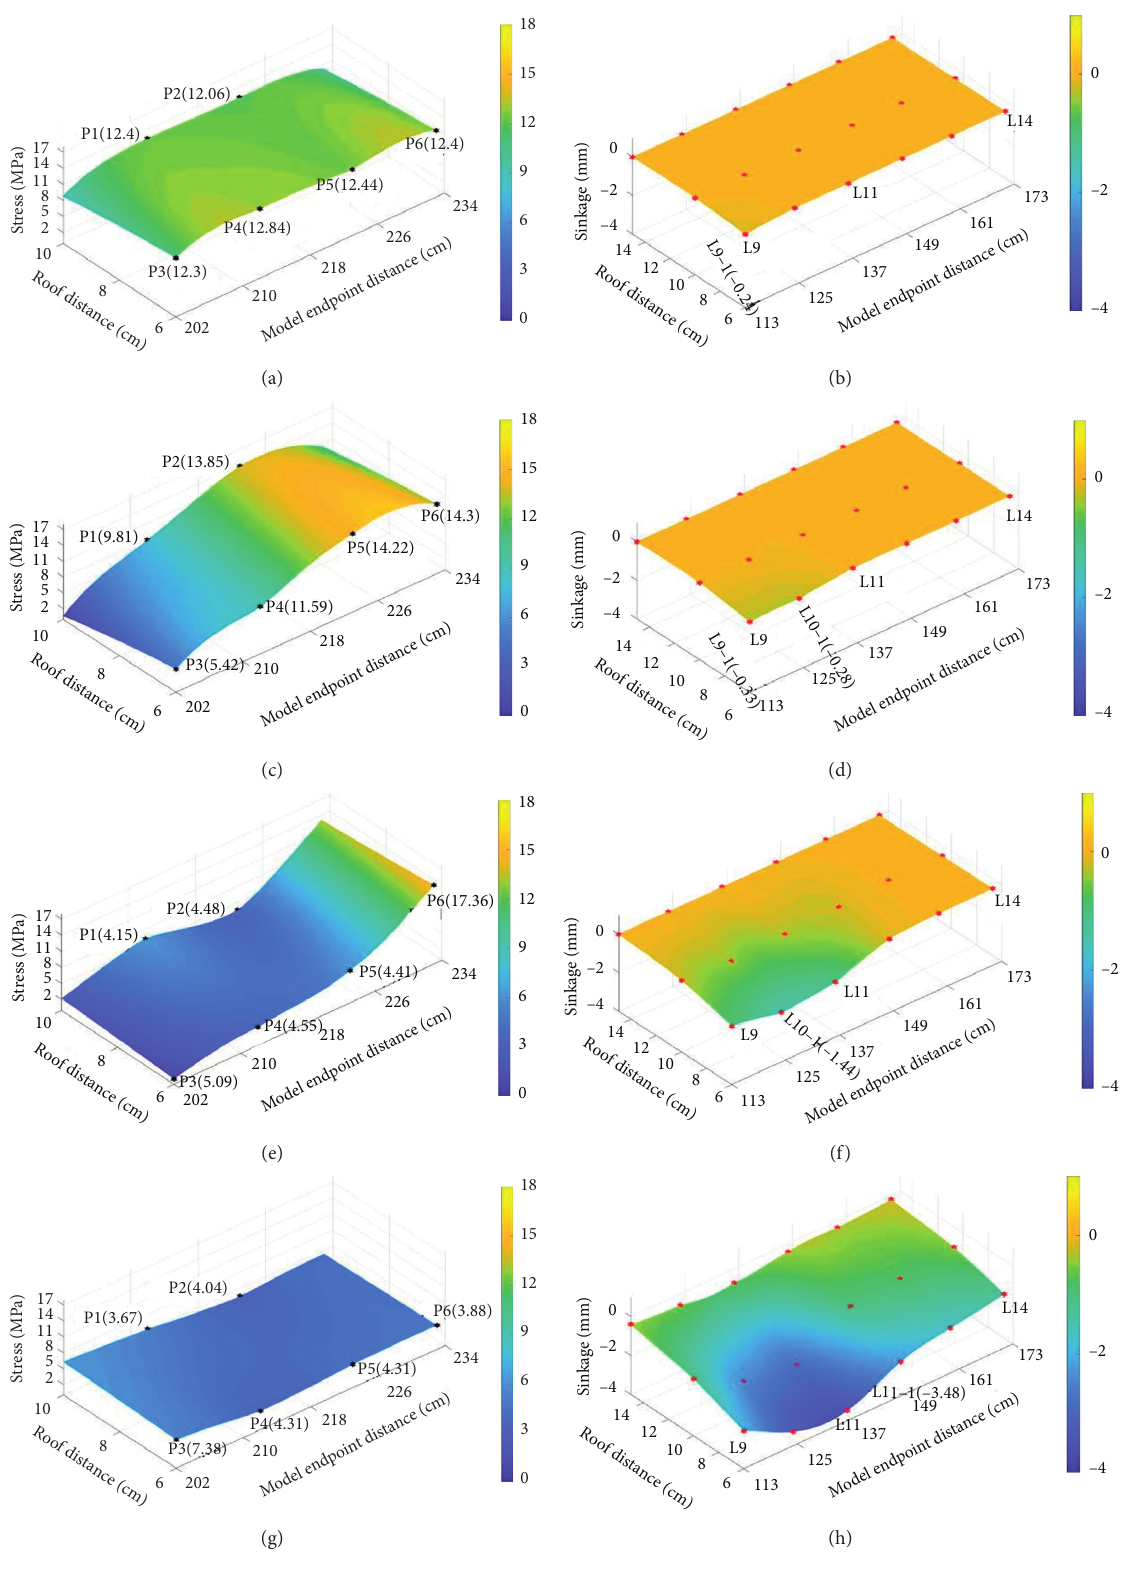
Figure 10: Lower roof stress and overlying rock subsidence in the four-step excavation of the stope structure with 8m ore pillars: (a, b) first step; (c, d) second step; (e, f) third step; and (g, h) fourth